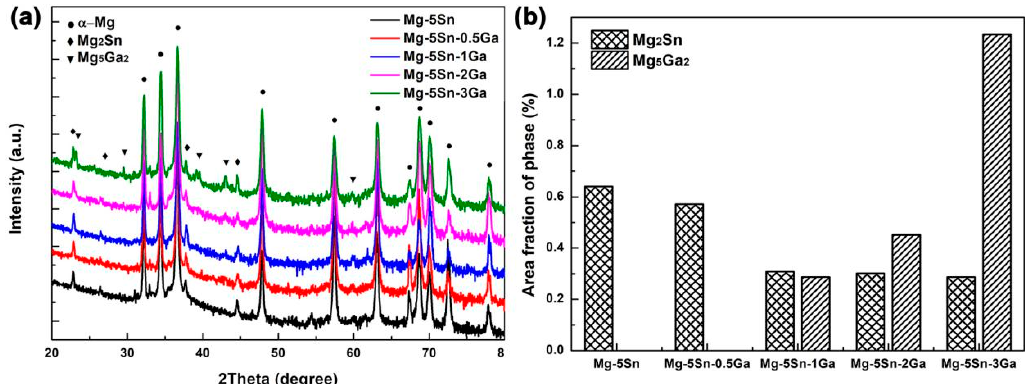
4 of 17 Figure 2. BSE micrographs of the Mg–5Sn– x Ga alloys: ( a ) Mg–5Sn, ( b ) Mg–5Sn–0.5Ga, ( c ) Mg–5Sn– 1Ga, ( d ) Mg–5Sn–2Ga, ( e ) Mg–5Sn–3Ga. The inserts are zoom-in views showing the second phases. ( f – i ) Elemental mapping of the Mg, Sn, and Ga in the Mg–5Sn–3Ga sample using electron microprobe analyzer (EPMA). Table 3. The chemical compositions of the phases measured by WDS as indicated by the arrows in Figure 2f (in at %).